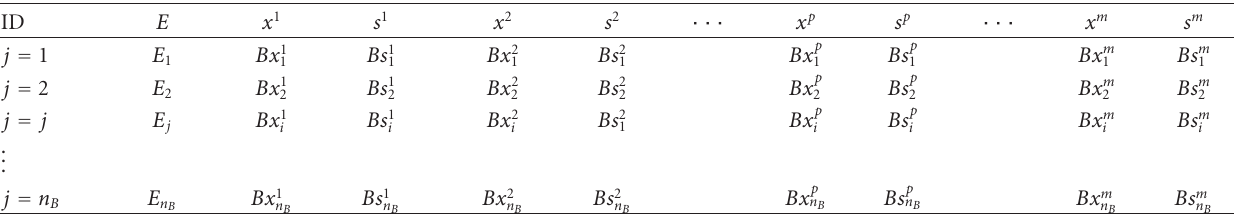
Table 2: The validation candidate dataset. It shows the validation candidate dataset. The ID (cid:3) column is identity objects, but their order is dependent to the order of the validation variable, order E . We generated the candidate score variables, { Bx 1 ej , ... , Bx